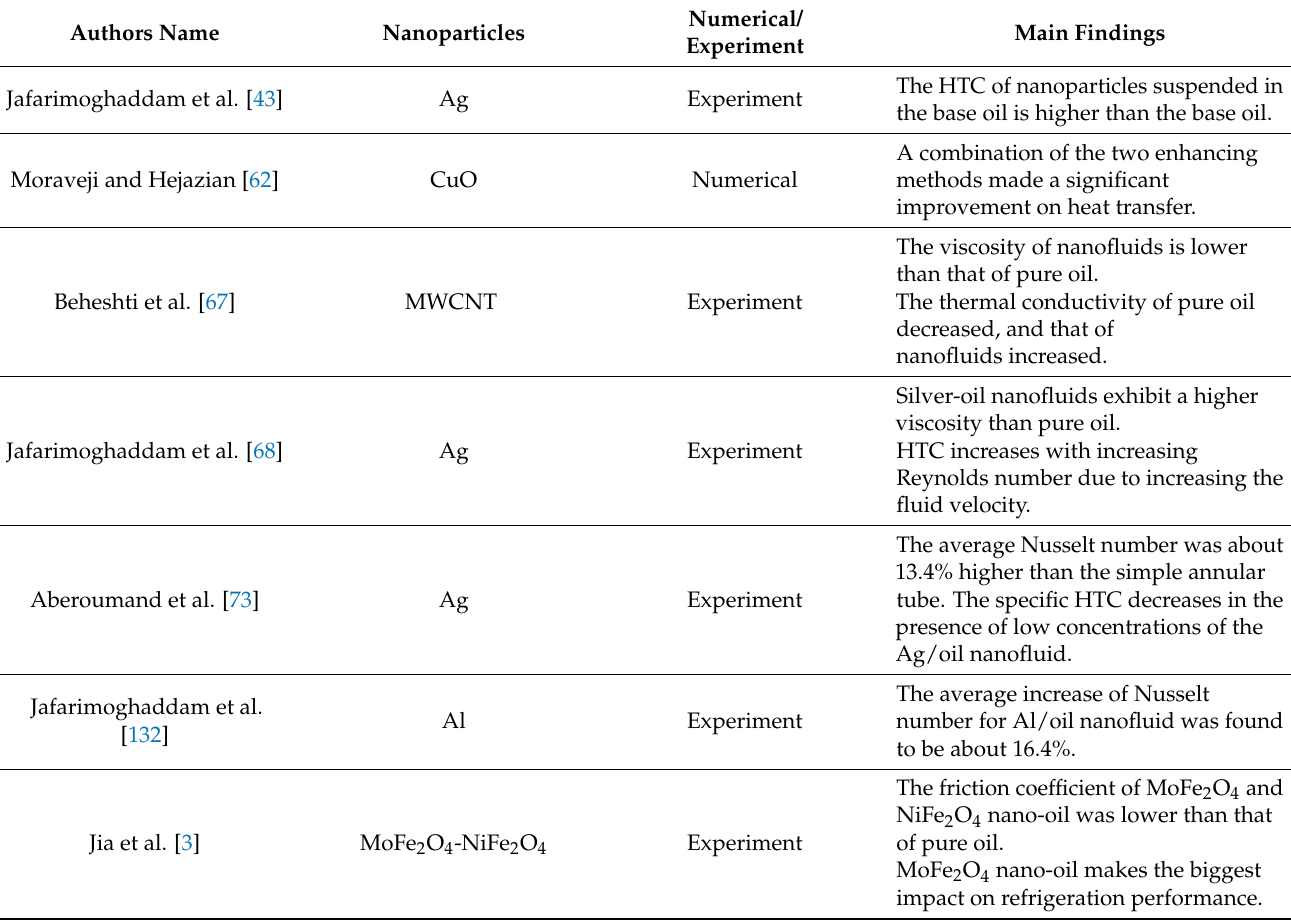
Table 9. Comparison of previous investigations on pure oil-based